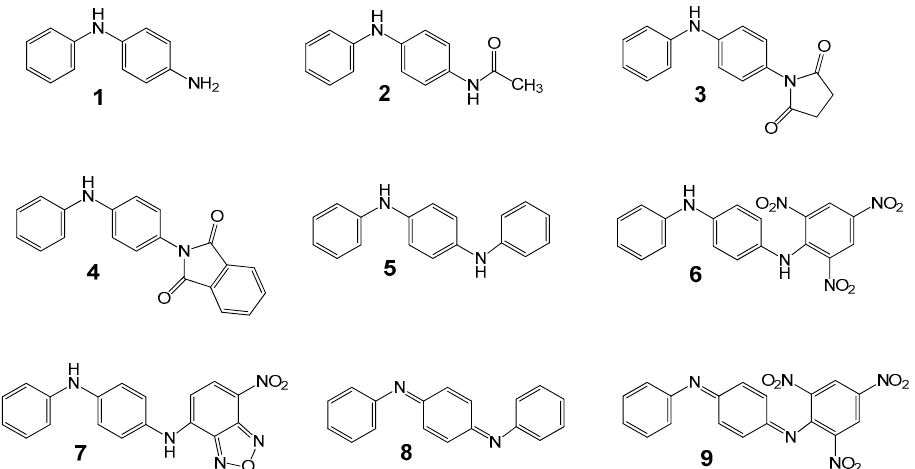
Figure 1. Chemical structures of the compounds used in this study.